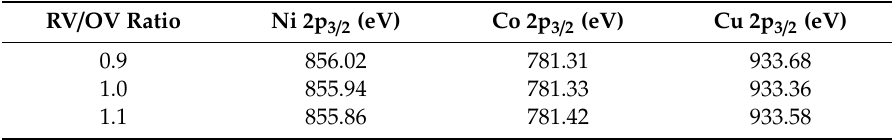
Table 3. BEs of the Ni 2p 3 / 2 , Co 2p 3 / 2 , and Cu 2p 3 / 2 XP spectra for 10MAl − x calcined